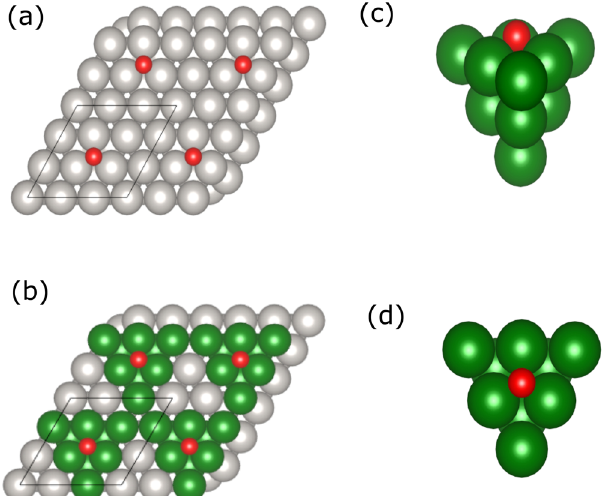
Fig.5|Extractionofclusterfromperiodiccalculation. OadsorbedonPt(111)( a ). Selectionofthecluster(green)usedinthecorrectivescheme( b ).ClusterwithO/Pt atoms (side ( c ) and top ( d ) views) obtained from the periodic